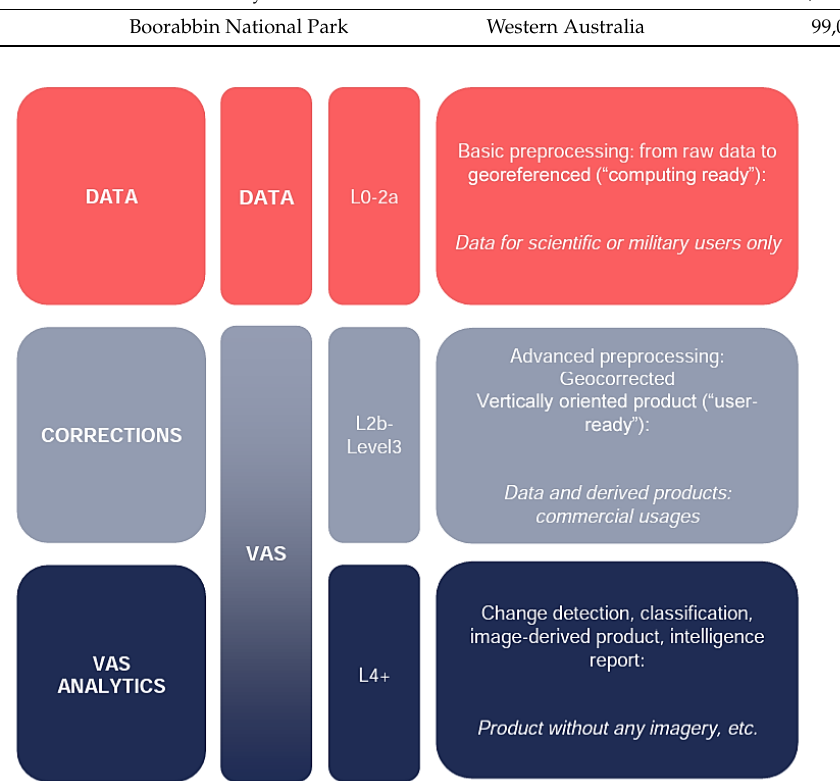
Figure 2. Levels of processing from data to services